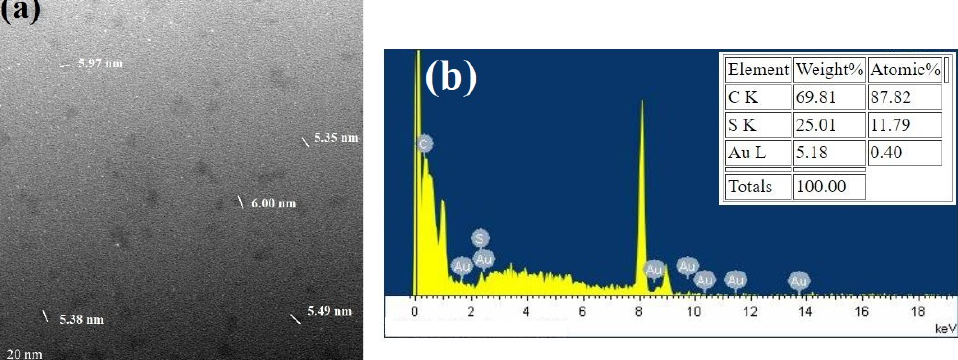
Figure 3. ( a ) TEM image of Au NCs. The sizes of the particles are between 5~6 nm. ( b ) Energy dispersive X-ray spectrometer (EDS) analysis results: the particles are comprised of C, S, and Au elements (upper panel). No Ag element was detected.